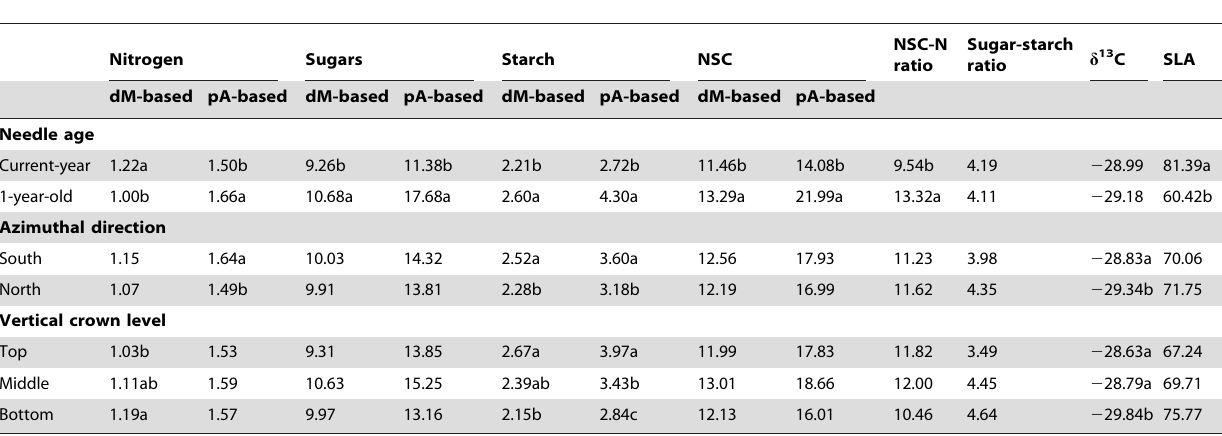
Table 3. Mean values ( n =15) of concentrations of needle soluble sugars, starch, non-structural carbohydrates (NSC), and total nitrogen expressed on a dry mass basis (dM-based, % d.m.) and on a projected area basis (pA-based, g m –2 ), as well as NSC-N ratio, d 13 C content values ( % ), and SLA (cm 2 g –1 ) in needles within Pinus koraiensis tree crown.